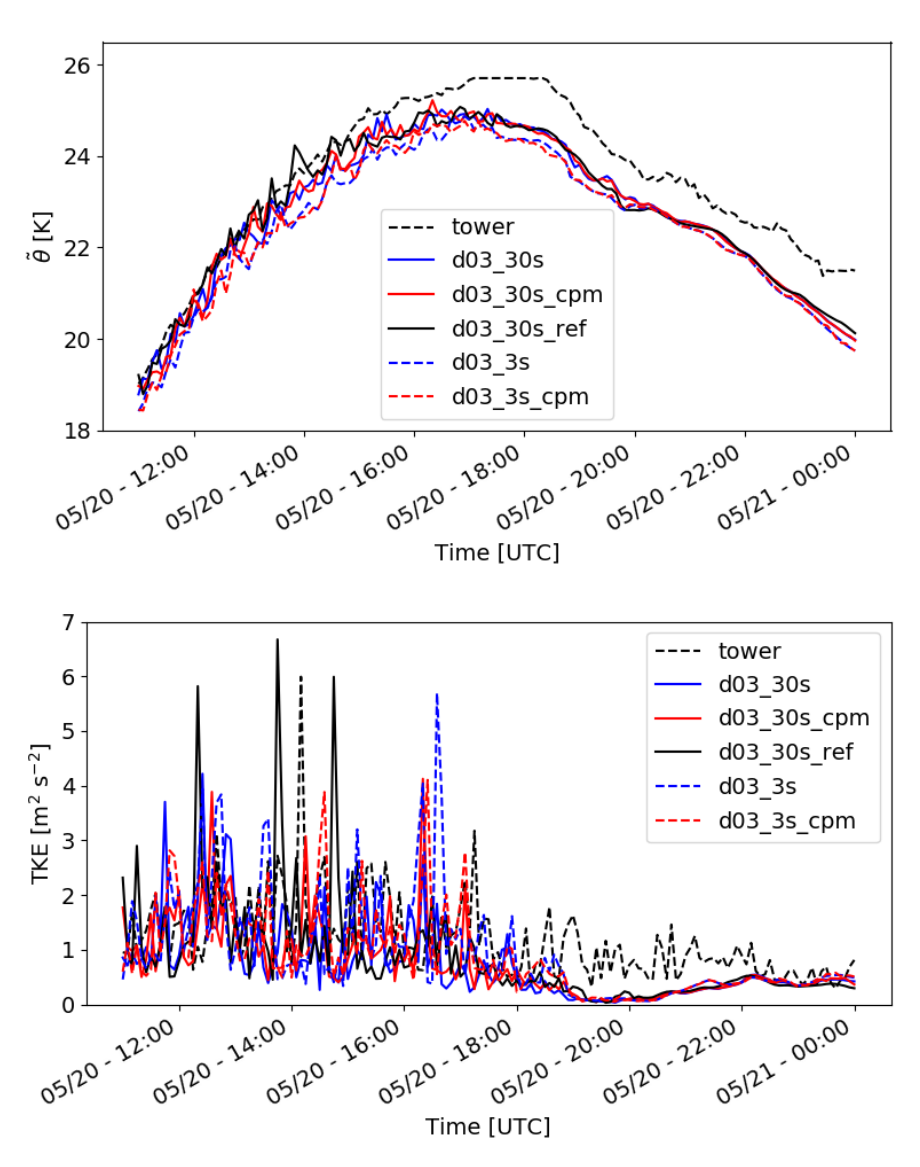
Figure 5. Temperature ( top ) and TKE ( bottom ) time series from 100 m a.g.l. at a tower, tse04, on the ridge of the Vale do